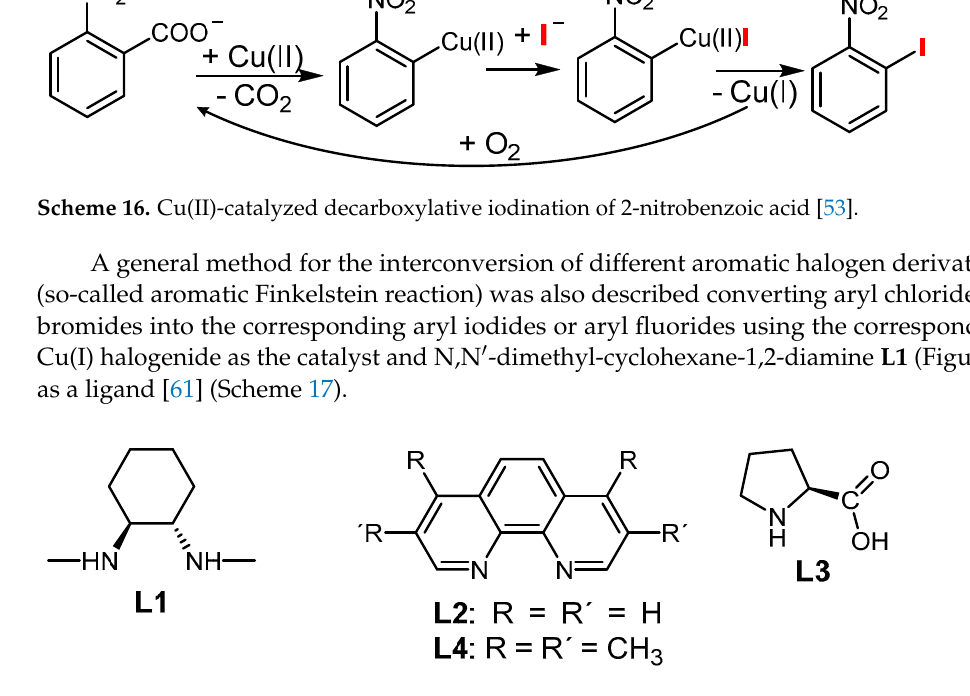
Figure 1. Structures of ligands used for aromatic Finkelstein reaction [55,61–63].